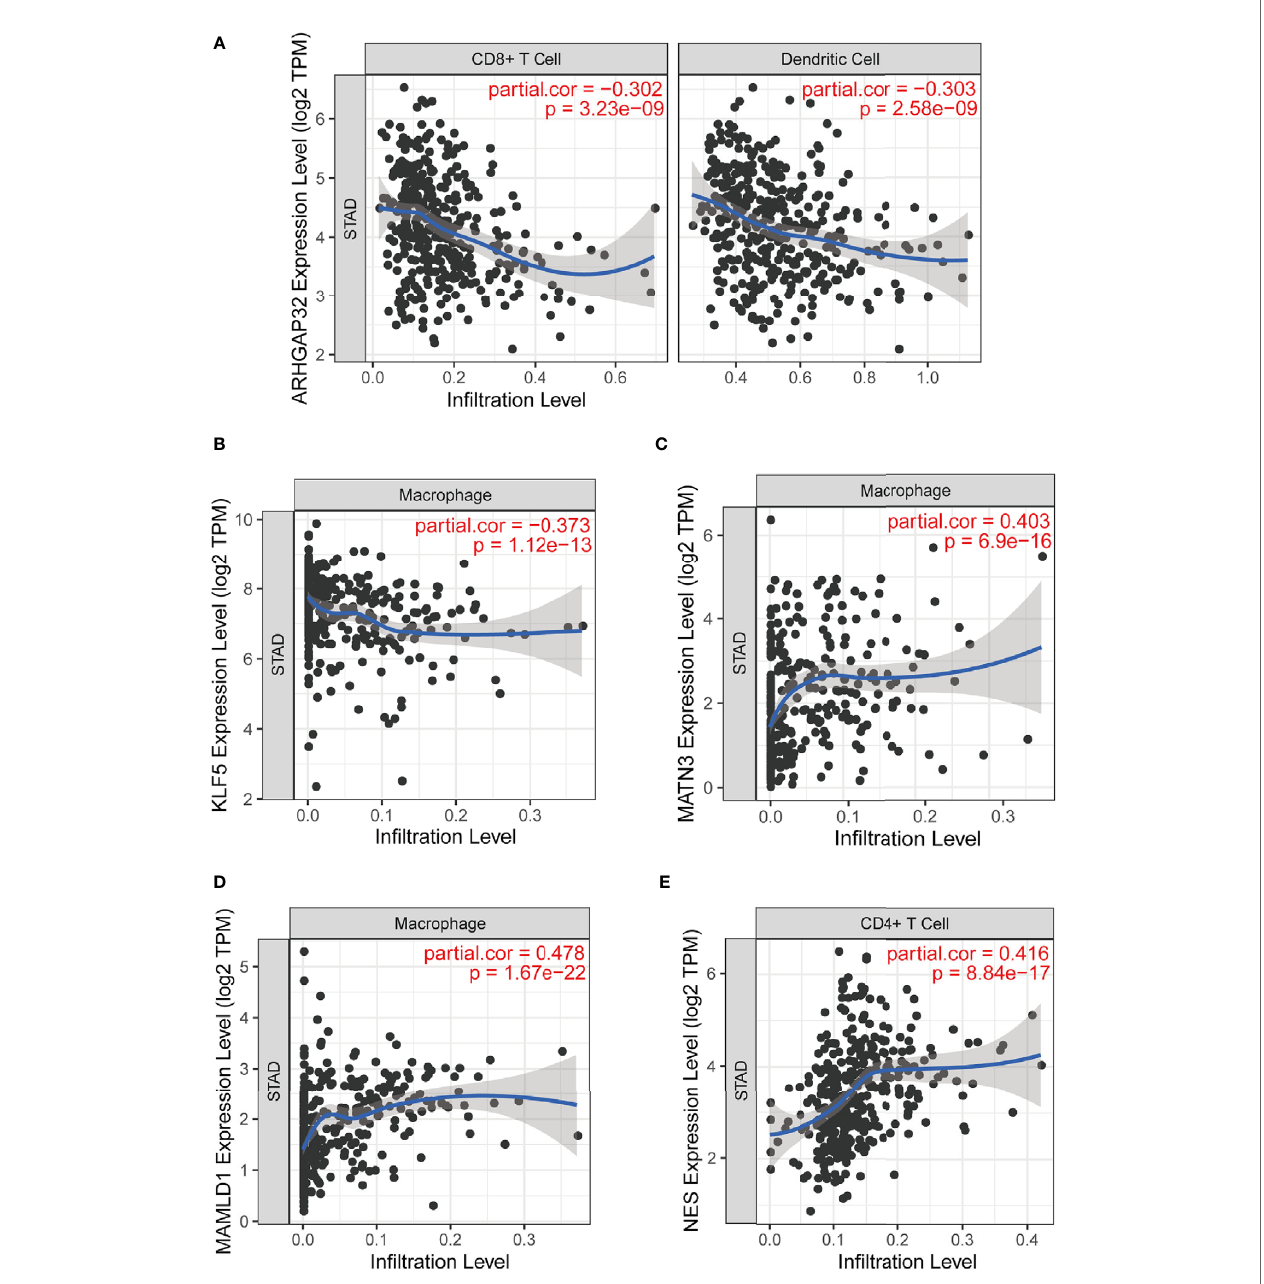
FIGURE 11 | Part of relationships between model genes and immune cells evaluated by TIMER. (A) ARHGAP32 with CD8+ T cell and dendritic cell; (B) KLF5 and macrophage; (C) MATN3 and macrophage; (D) MAMLD1 and macrophage; (E) NES and CD4+ T